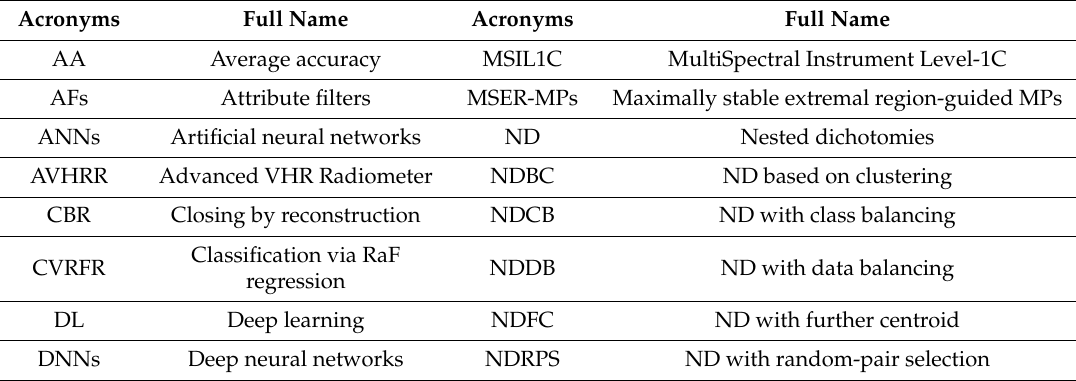
Table 1. Acronyms with corresponding full names used in this